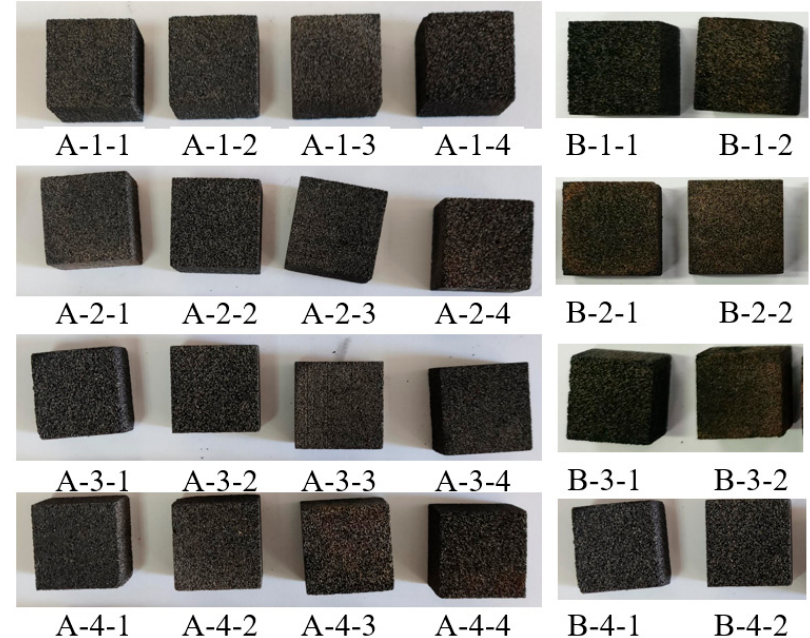
Figure 1. Specimens before experiment.